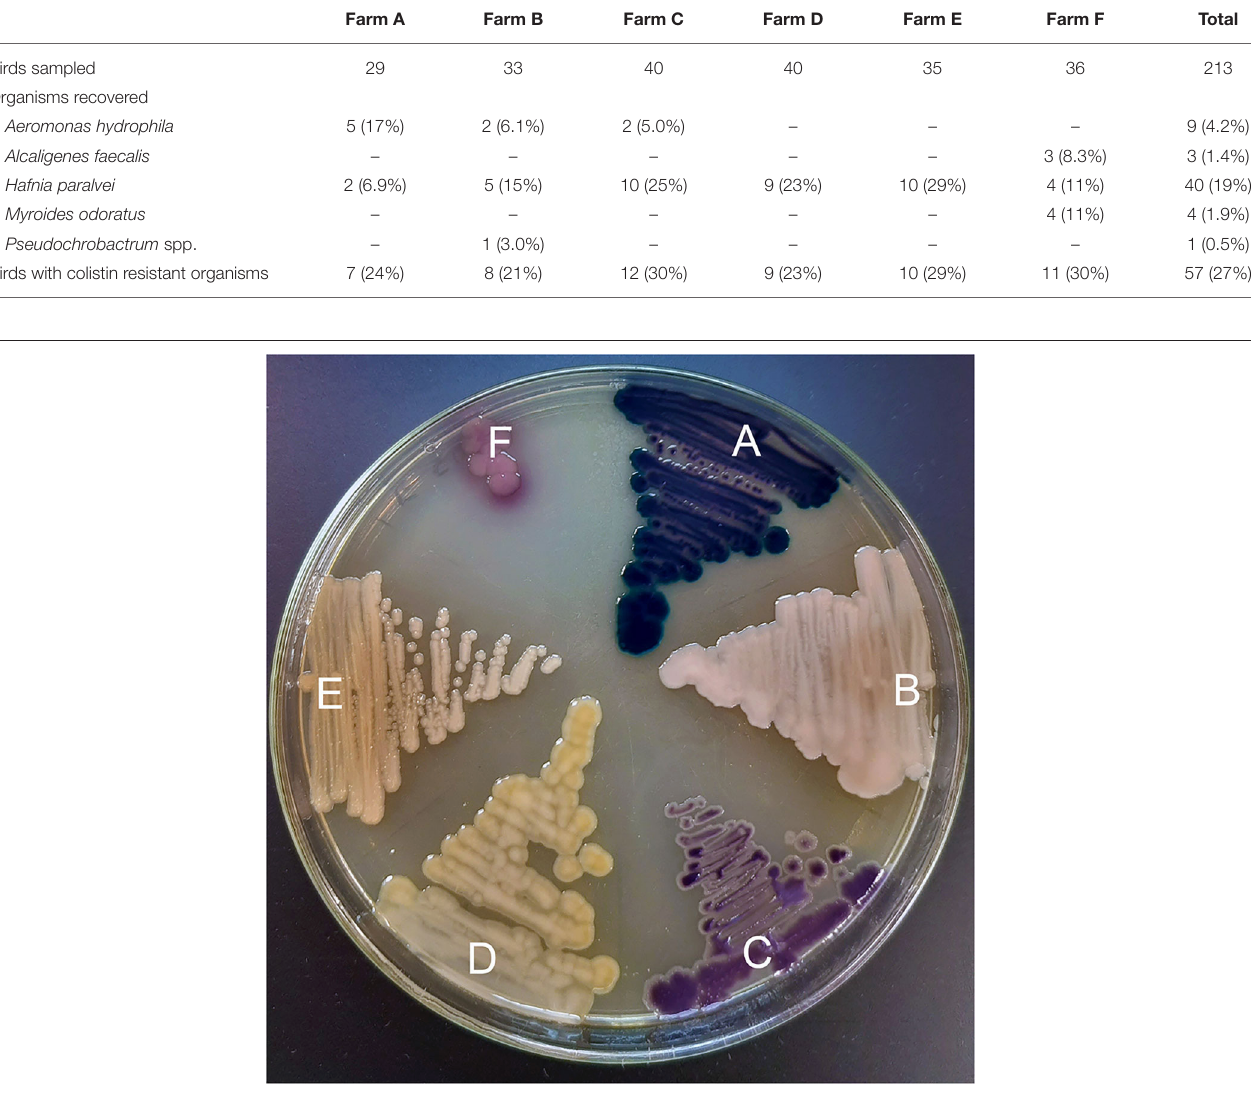
TABLE 1 | Distribution of polymyxin-resistant organisms recovered from Victorian poultry farms.